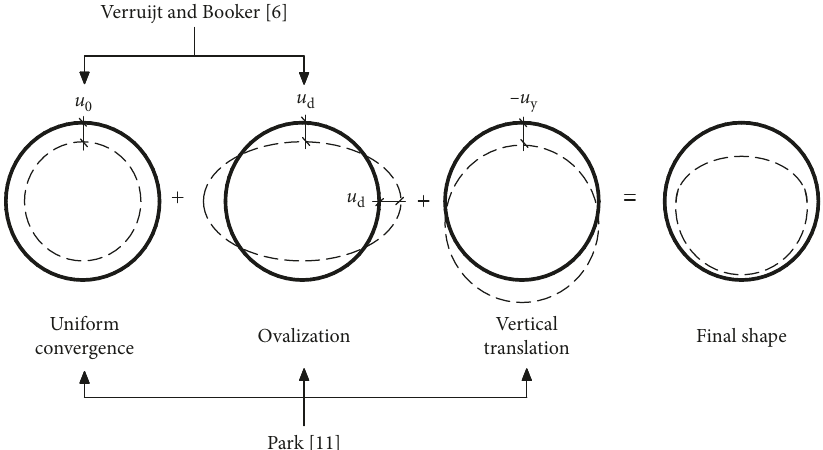
Figure 7: Boundary conditions of shallow tunnels summarized by Pinto and Whittle [13].